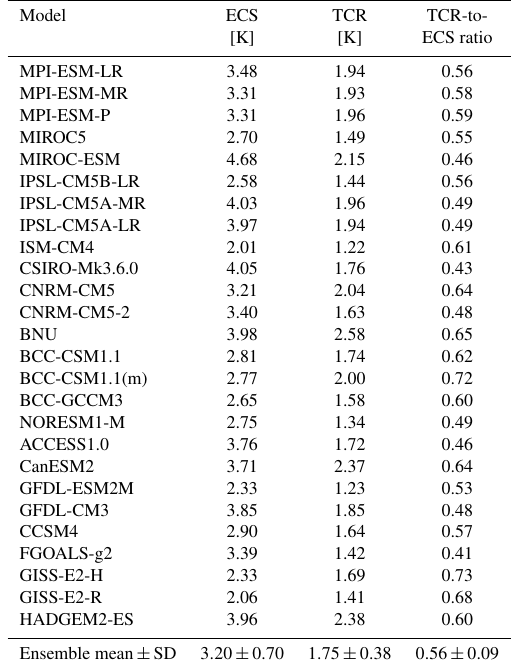
Table A2. List of CMIP5 models and climate sensitivity parame-